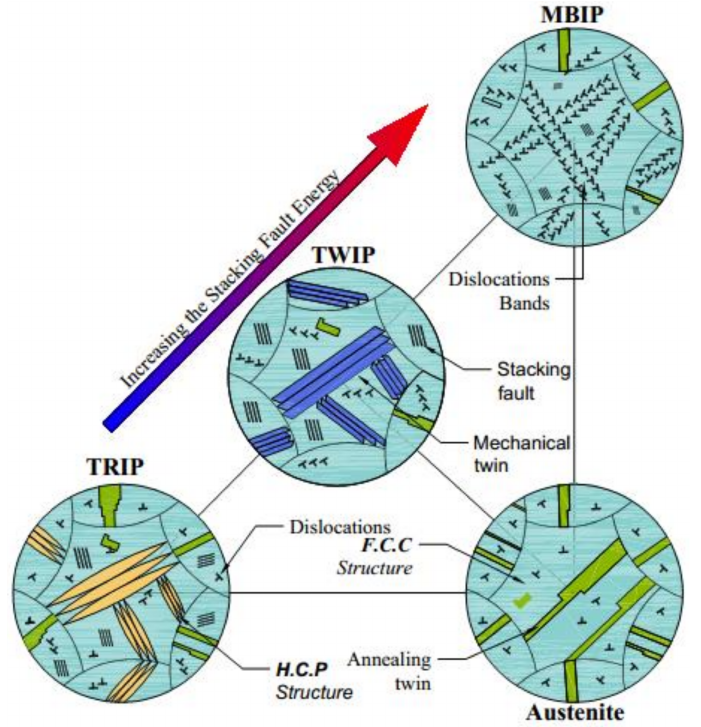
Figure 2. Schematic representation of the plastic deformation mechanisms in austenitic manganese steels.